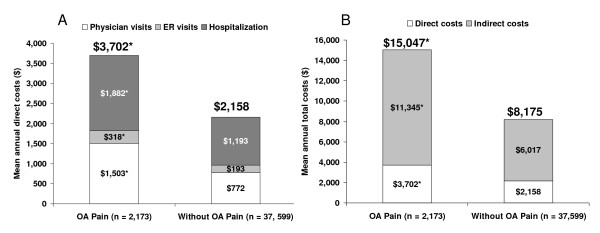
Unadjusted mean annual costs in the OA pain and comparator cohorts. A) Direct medical costs for provider visits. B) Total costs including estimated indirect costs plus direct medical costs of provider visits.*P < 0.0001 versus controls.